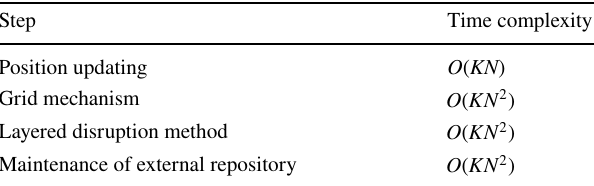
Table 2 lists the reliability analysis results of the four methods on example 1. The relative error of FORM to MCS